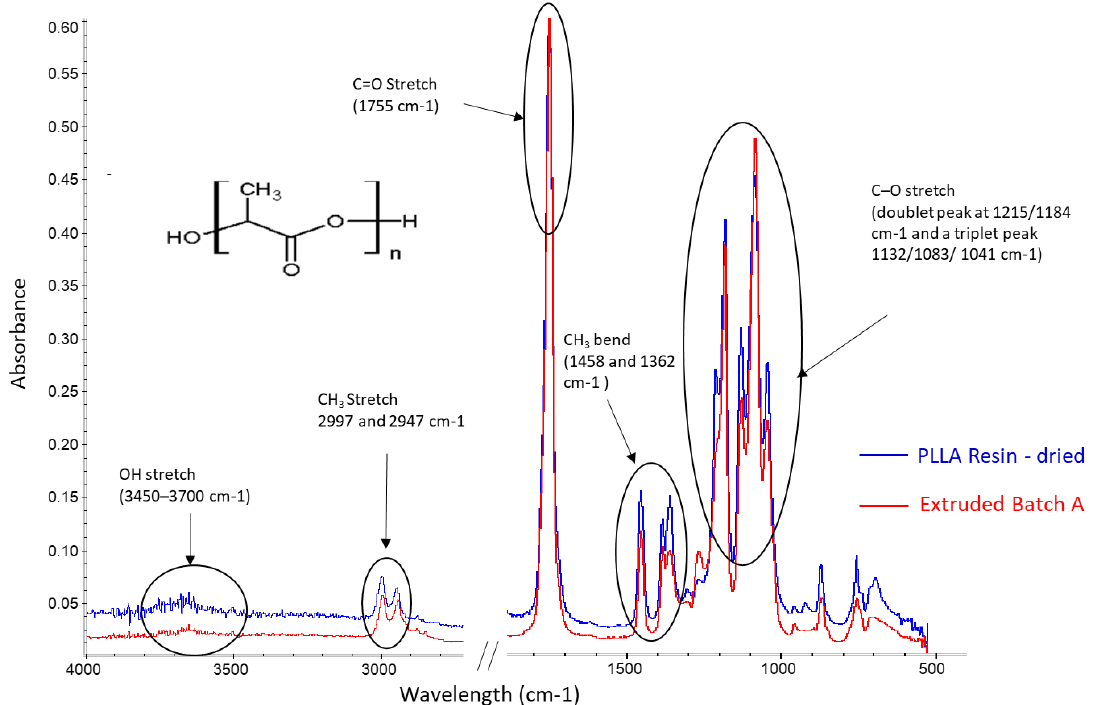
Figure 6. FTIR Spectra of dried resin (blue) and Batch A extruded tubing (red) in the wavelength range of 4000–500 cm −1 .